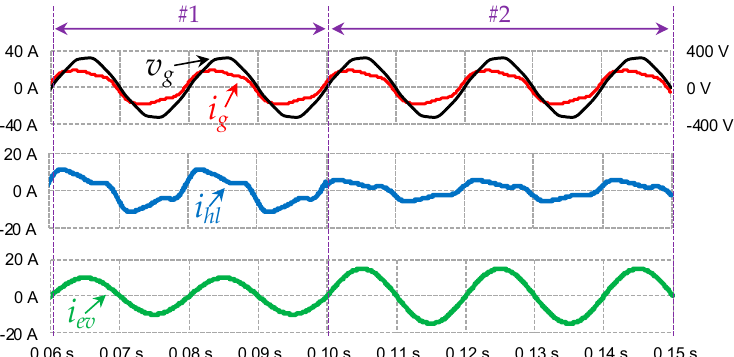
Figure 6. Principle of operation representative of the controlled G2V mode.